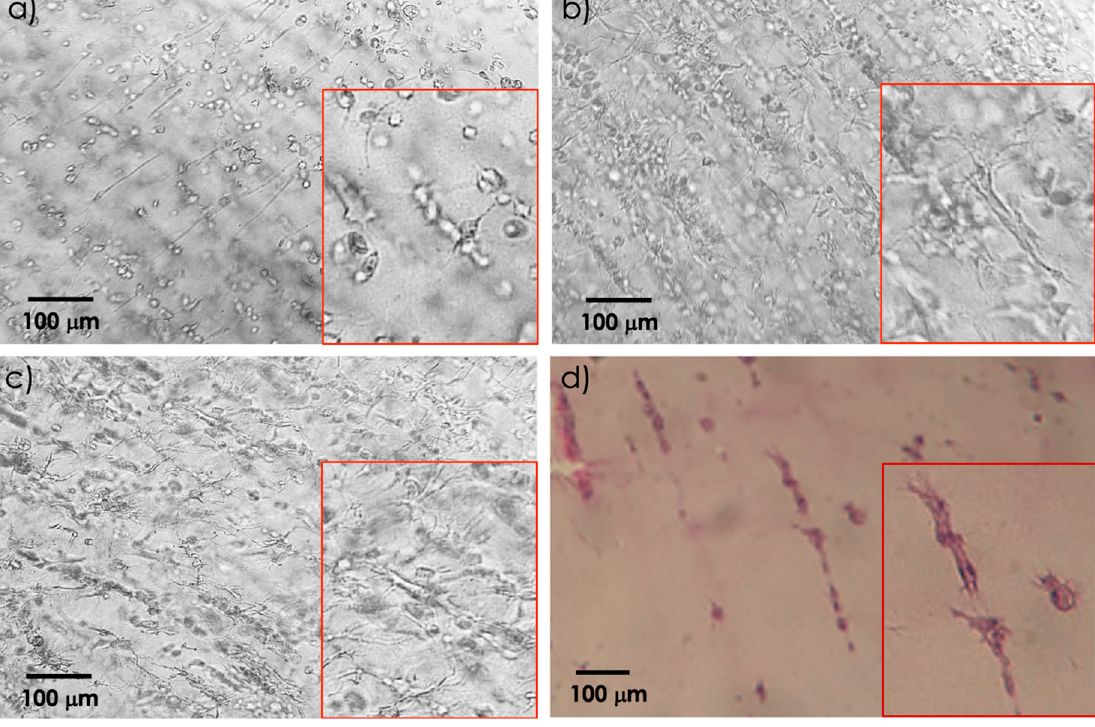
Figure 8. Aligned HFF in fibrin clot maintained in culture for 24 ( a ), 48 ( b ), and 72 h ( c ) with higher magnification boxes. Histological section of (hematoxylin and eosin)-stained cells at 72 h ( d ) with a higher magnification box.